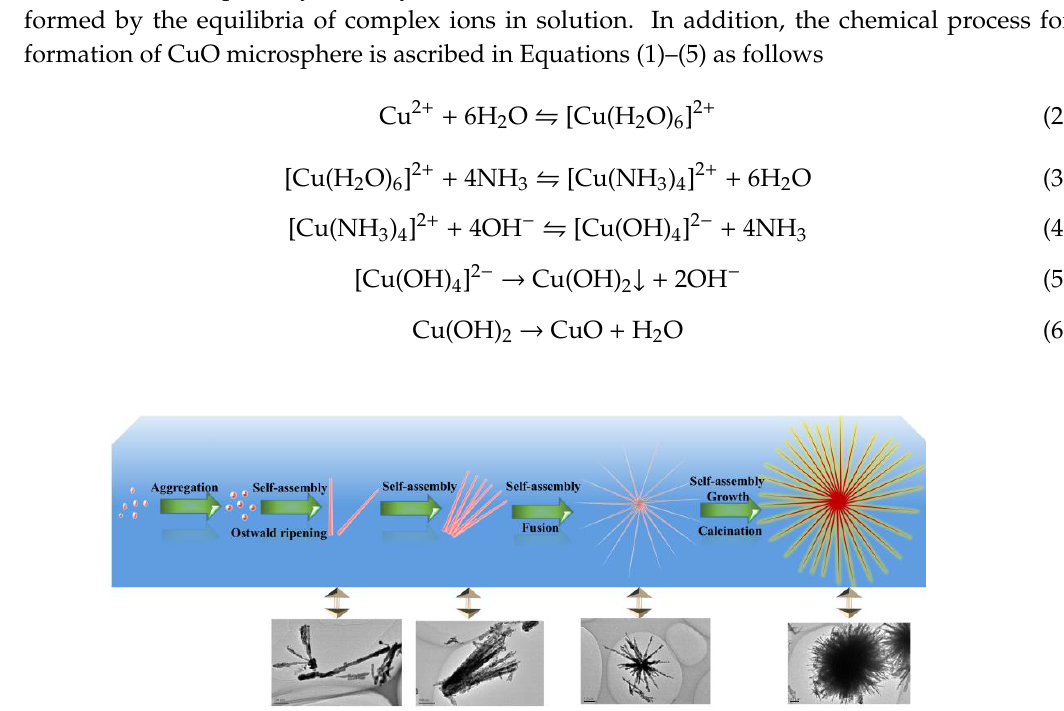
Scheme 1. Schematic illustration of the possible formation mechanism for the urchin-like CuO structure.